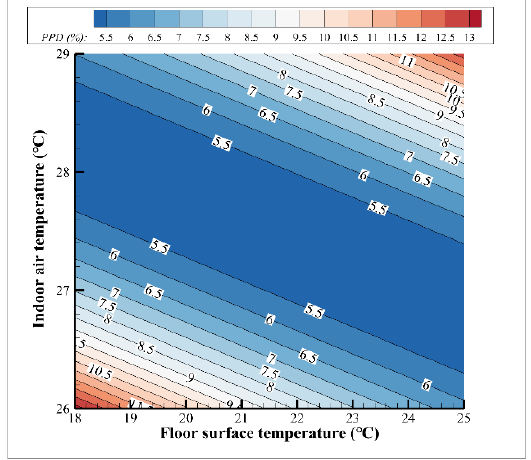
Figure 5. Relationship between PPD and two temperature indexes.